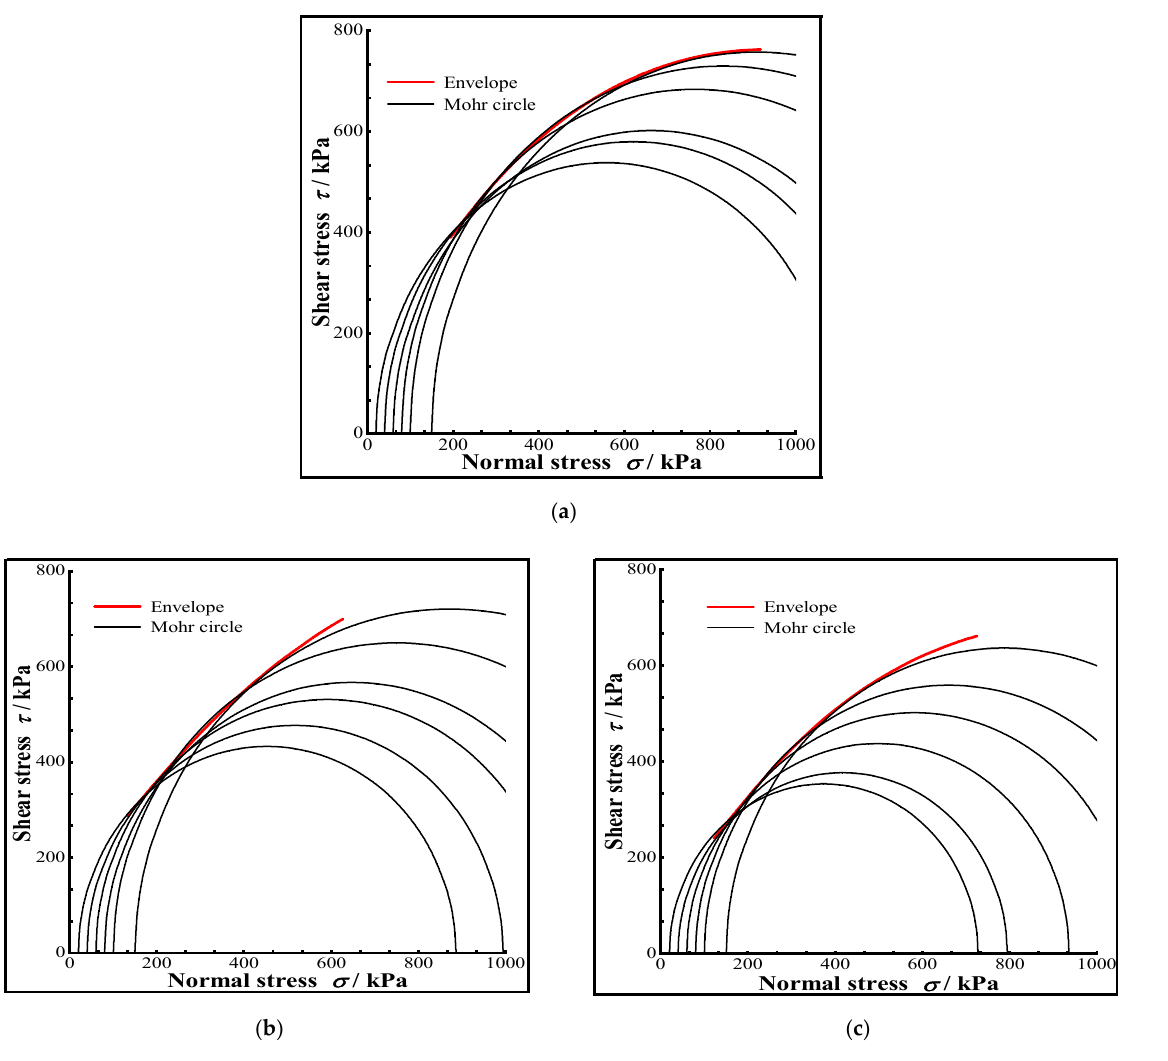
Figure 7. The strength envelopes of CIL under different conditions, ( a ) The condition without F-T cycle, ( b ) The freezing condition of −5 °C and the tenth F-T cycle, ( c ) The freezing condition of−10 °C and the sixth F-T cycle.